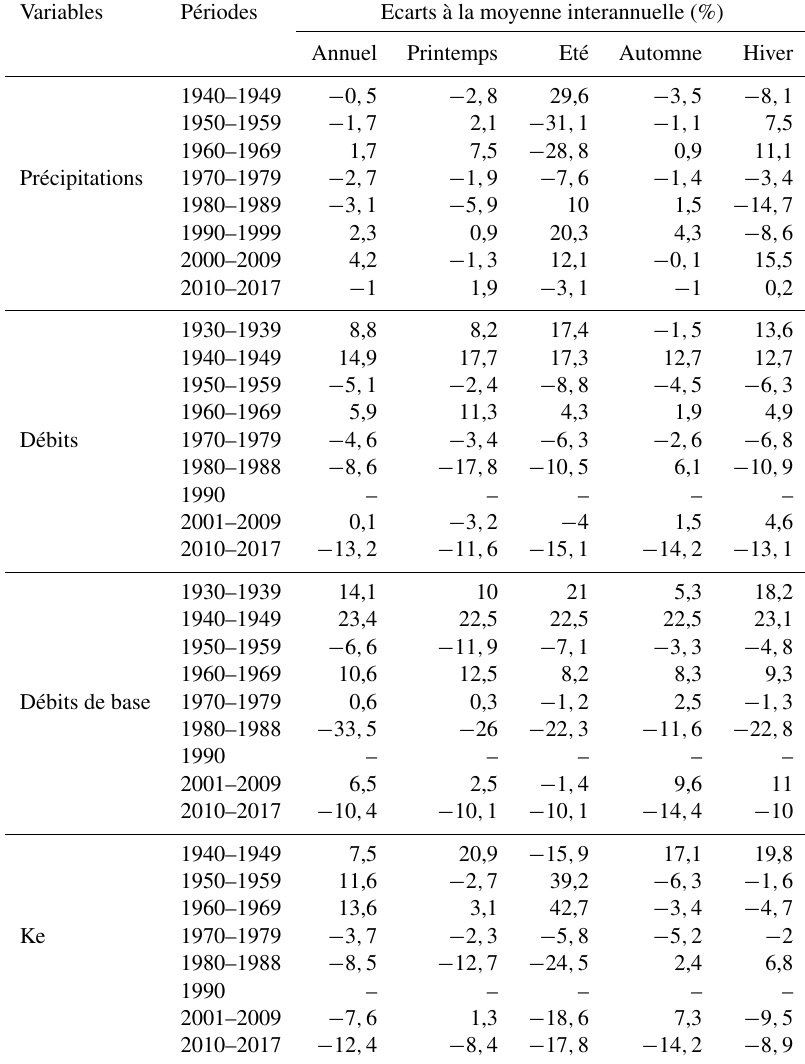
Tableau 1. Ecarts (%) des moyennes décennales annuelles et saisonnières des pluies, débits, débits de base et coefficients d’écoulement par rapport à leurs moyennes interannuelles sur le bassin